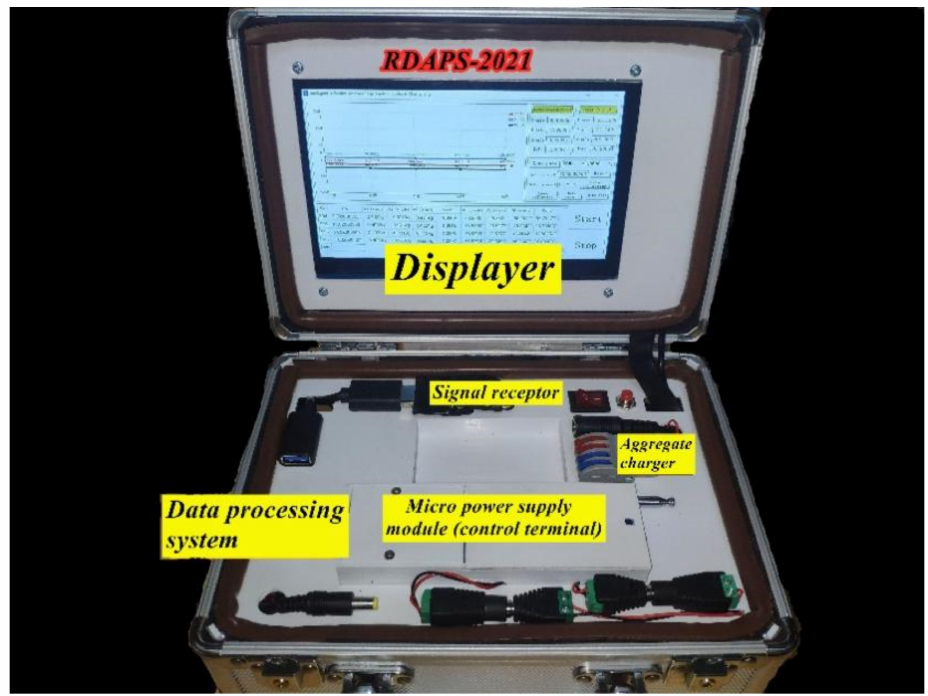
Figure 5. Hardware equipment of